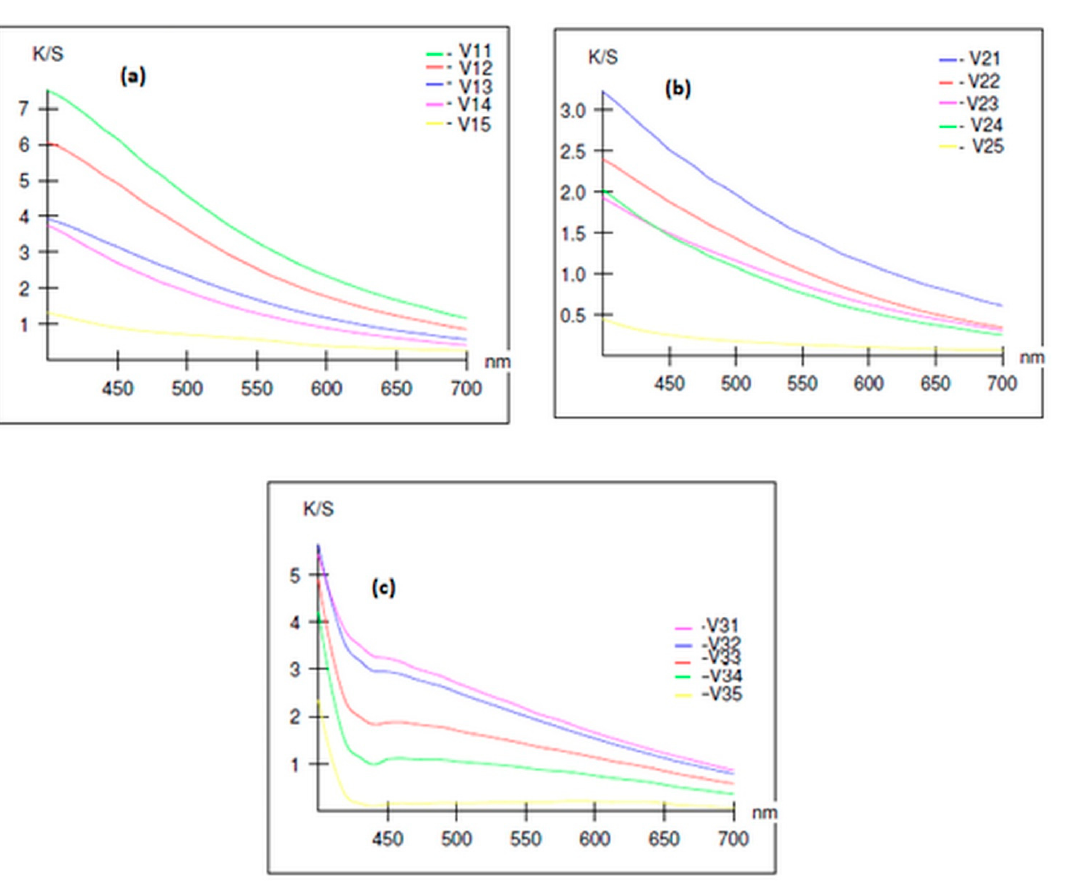
Figure 12. Variation in the colour strength of composite materials obtained from: ( a ) polypropylene/hemp fibres; ( b ) bicomponent/hemp fibres; ( c ) recycled polyester/hemp fibres.